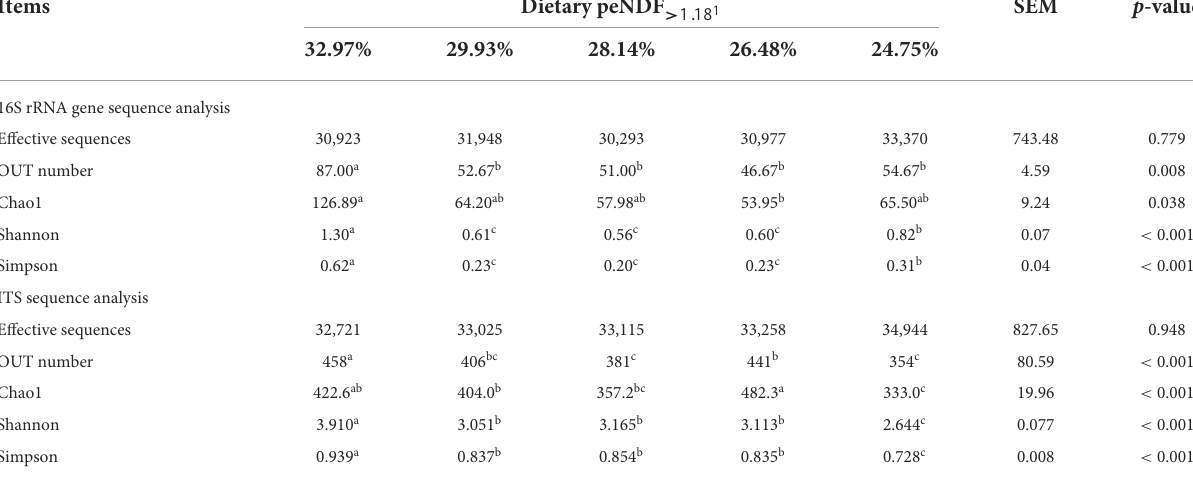
TABLE 6 Effects of different contents of peNDF > 1.18 in diets on rumen microbial OTUs and alpha diversity of